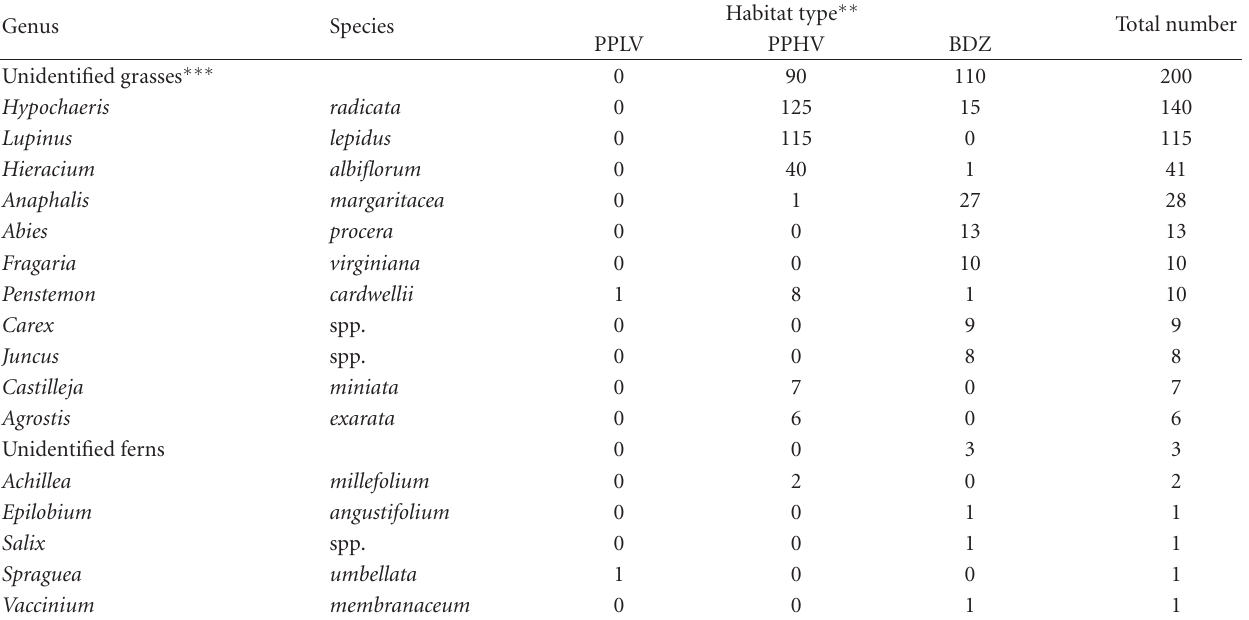
Table 6: List of plant species and numbers found in each habitat type at Mount St. Helens National Volcanic Monument between 22 and 25 July 2008 ∗ .